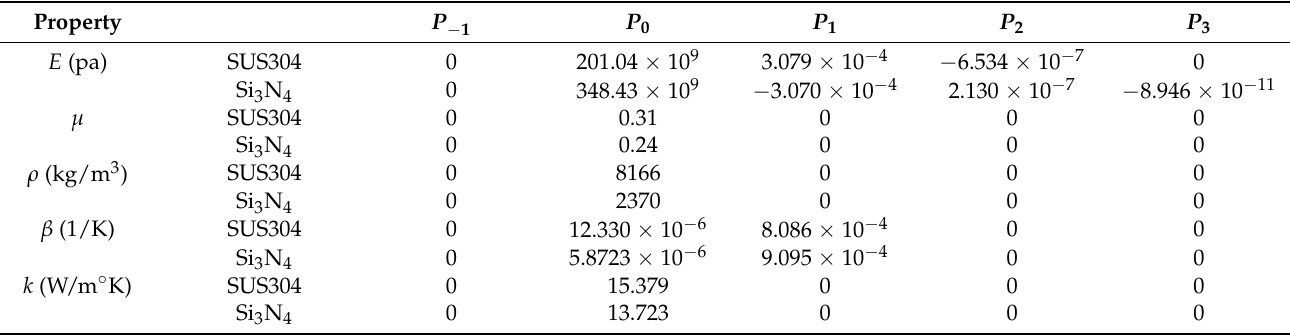
Table 2. Material properties of a functionally graded conical shell.